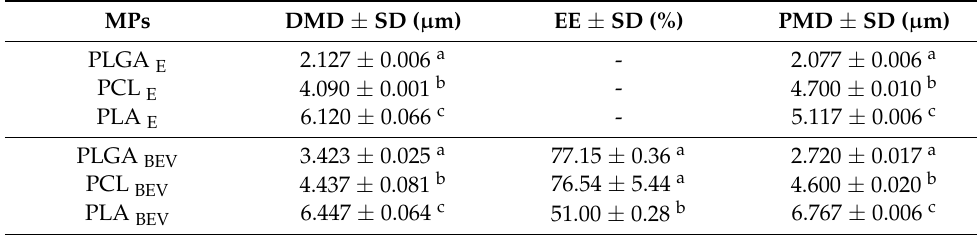
Table 1. DMD, EE of BEV-loaded MPs, and PMD of microcarriers prepared working with different polymers. Different letters (a, b, and c) reported in the DMD, EE, and PMD columns refer to statistically significant differences among the three different samples (empty or loaded) for each type of carrier ( p < 0.05), using ANOVA with Tukey’s HSD post hoc multiple comparison test. Results are expressed as mean value ± standard deviation ( n = 3). MPs: microparticles, DMD: droplet mean diameter, SD: standard deviation, EE: entrapment efficiency, PMD: particle mean diameter, E: empty, BEV: bevacizumab, PLGA: poly(lactic- co -glycolic acid), PCL: poly( ε -caprolactone), PLA: poly(lactic